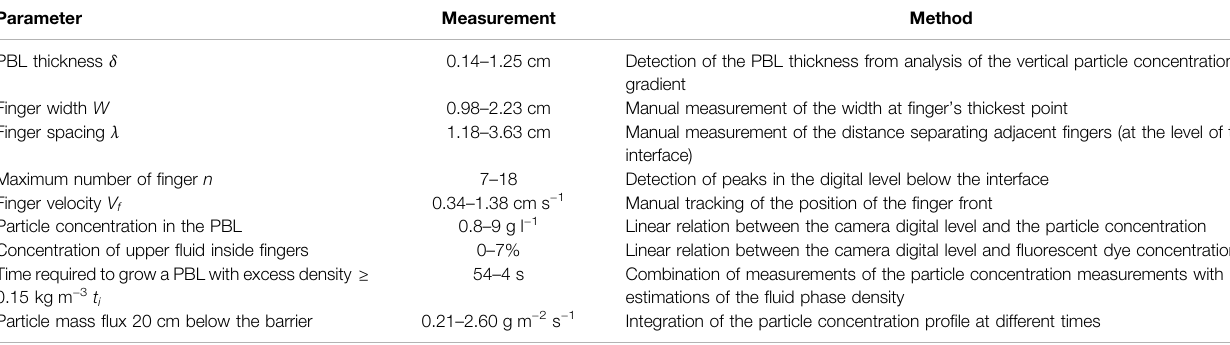
TABLE 3 | Summary of the measurements performed in type A